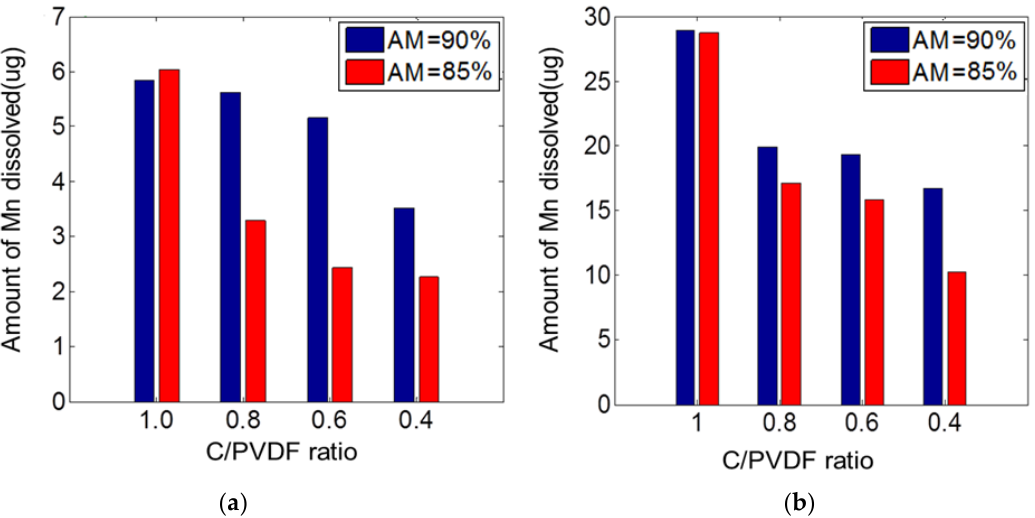
Figure 2. The amount of manganese dissolved in the electrolyte with different C/PVDF ratios after ( a ) 15 cycles and ( b ) 50